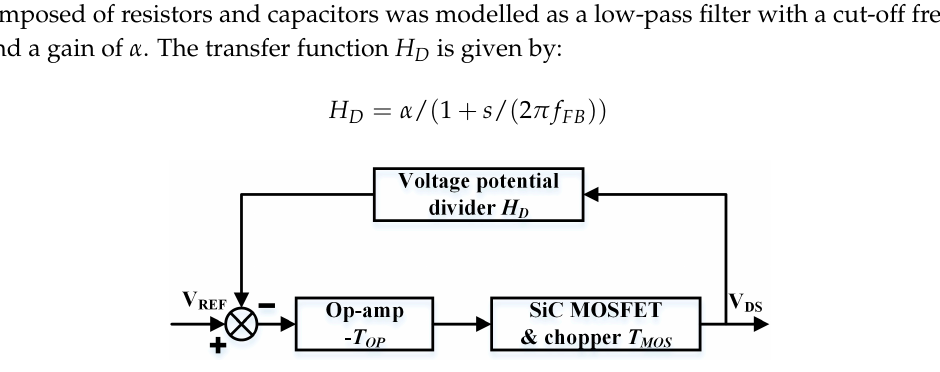
Figure 2. Control system representation of a MOSFET under closed-loop gate drive.